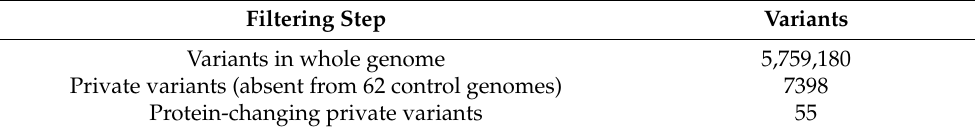
Table 1. Homozygous variants detected by whole genome re-sequencing of an affected